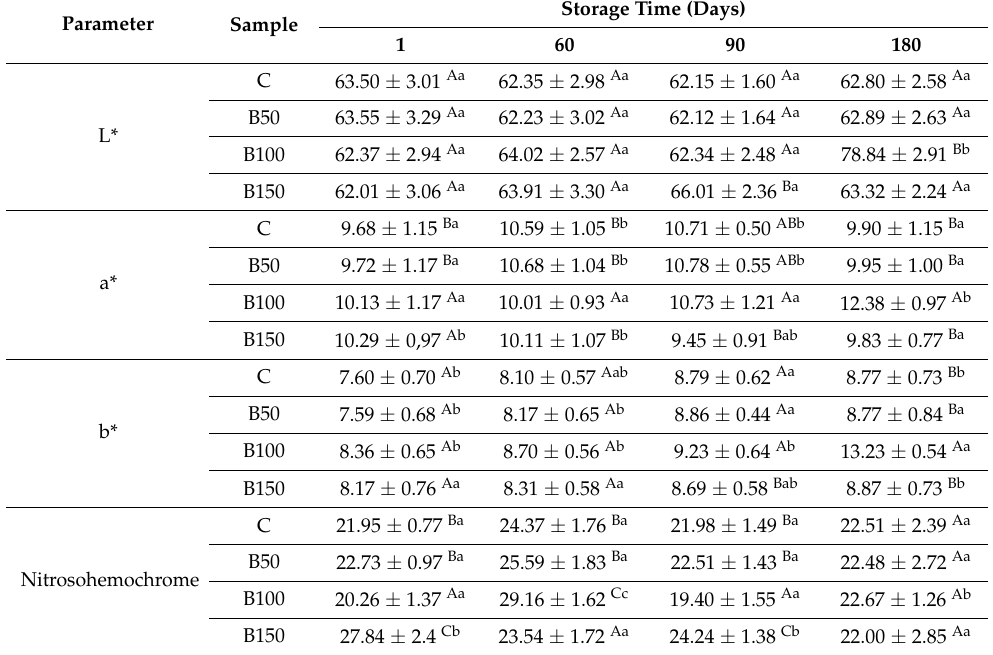
Table 3. The color properties (CIE L*a*b* system) and amount of meat pigment (nitrosohemochrome) in canned meat samples with a reduced amount of sodium nitrite and fortified with the extract of black currant